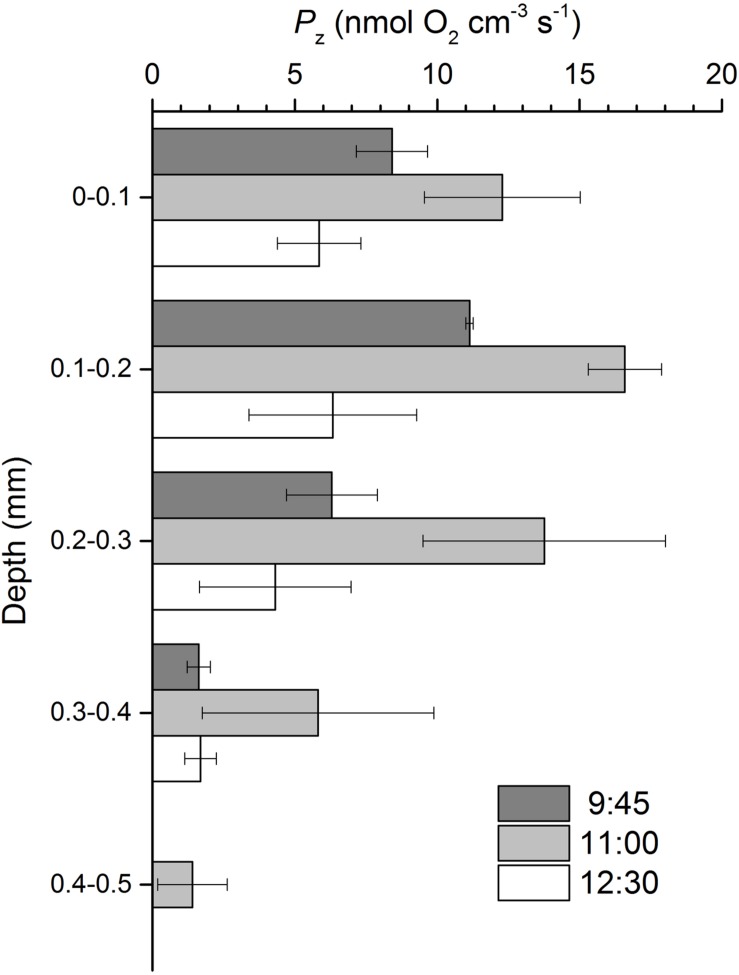
Gross photosynthesis (Pz) profiles in an intertidal sediment over a diel emersion period (mean ± standard deviation; n = 3). The illumination period was between 9 AM and 1 PM at a constant photon irradiance of 150 μmol photons m-2 s-1.